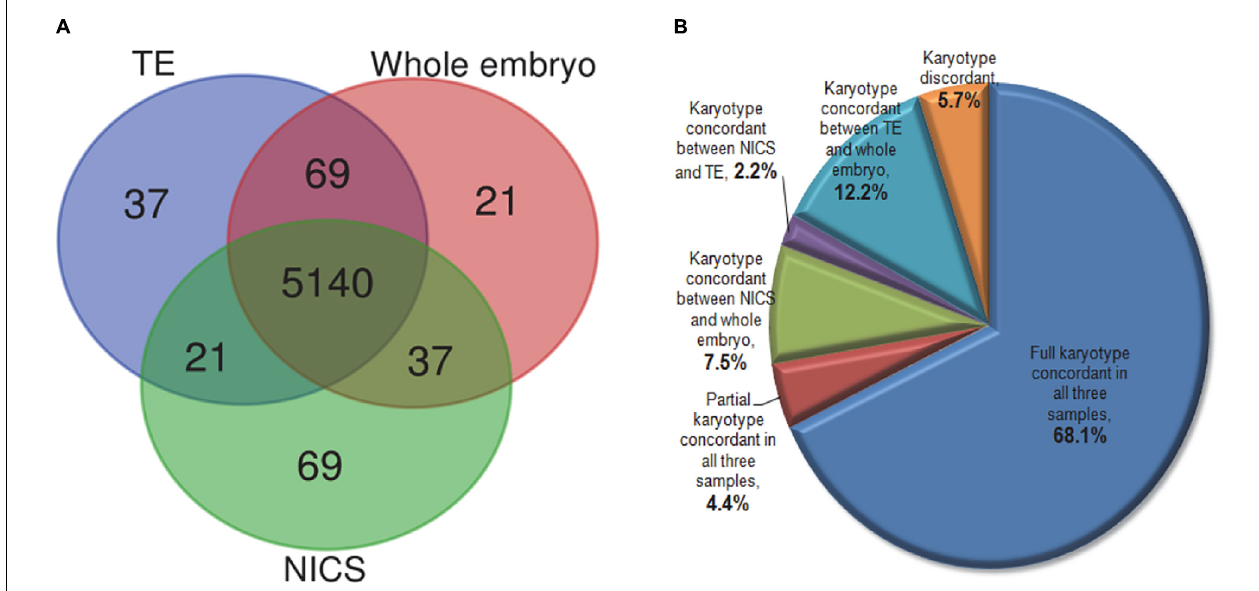
FIGURE 4 | The comparison of karyotype in TE, NICS, and whole embryo samples. (A) The Venn diagram of the concordance of chromosome ploidy compared in three types of samples. The ploidy for all 22 autosomes and chromosome X in 229 non-MAC embryos (23 × 229 = 5,267) were compared among TE biopsy, NICS, and whole embryo. (B) The distribution of embryos with different karyotype concordances. Full concordance was reported if samples of two assays were euploid or if identical chromosomes were abnormal (including mosaic and/or reciprocal losses and gains); partial concordance was reported when at least one abnormal chromosome corresponded in both assays under comparison. TABLE 2 | The performance of NICS versus TE-PGT on detecting chromosomal abnormalities after the exclusion of MAC embryos. Embryo N Assay Sensitivity % (95% CI) Specificity % (95% CI) NPV % (95% CI) PPV % (95%